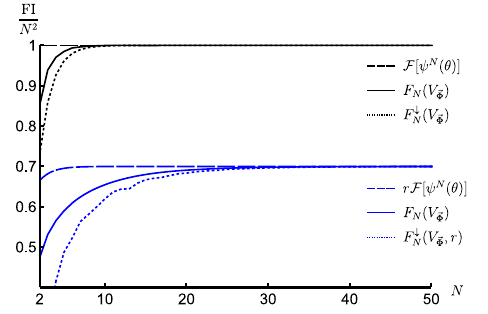
Fig. 5 | Attaining the ultimate HS of precision in presence of measurement imperfections and global unitary control. The case of phase estimation with N qubit probes is considered, which are initialised in a GHZ state, whereas the out- comes of ideal local measurements undergo an asymmetric bit- fl ip channel with p =0.95 and q =0.9. The black solid line is the exact (numerical) FI for a speci fi c choice of the control global unitary V ~ Φ , while the black dotted line is its lower bound F # N ð V ~ Φ Þ de fi ned in Eq. (20) — both converge to the optimal achievable F ½ ψ N ð θ Þ(cid:2) = N 2 (blackdashed line).The family of lines inblue are the corresponding FIs for the case of a distorted GHZ state, with an admixture of white noise (with r =0.7 in Eq. (18)) being